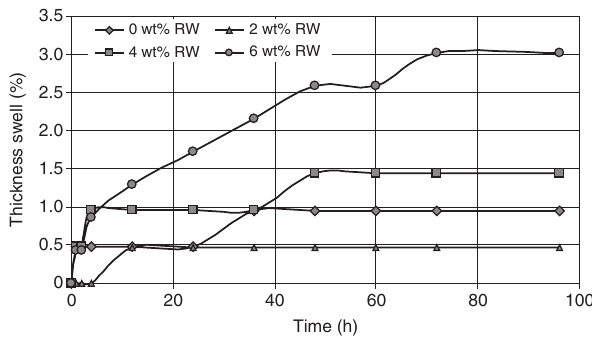
Figure 12 TS as a function of soaking time for different weight percentages of coconut fiber in RW.